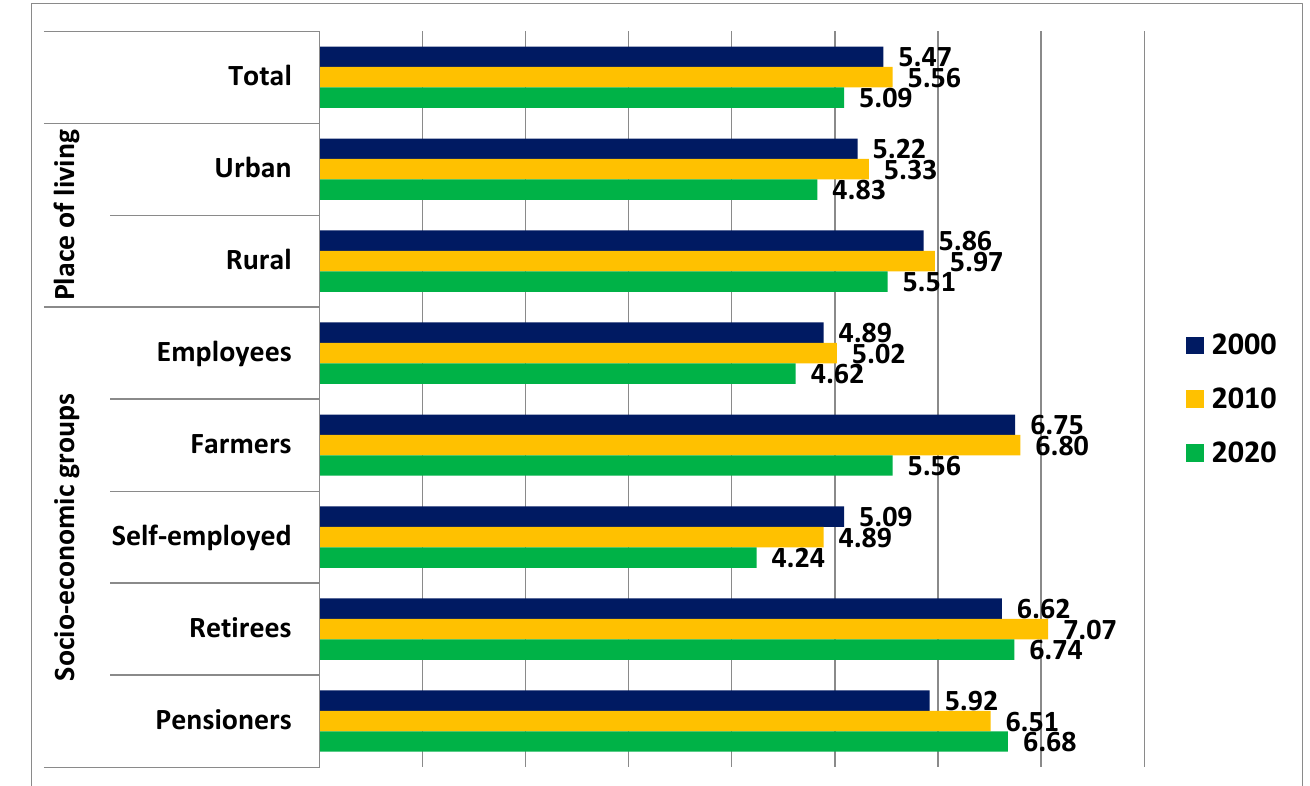
Figure 1. Total meat and meat product consumption in Polish households in 2000, 2010, and 2020 in terms of place of living and socio-economic group (kg/person/month).